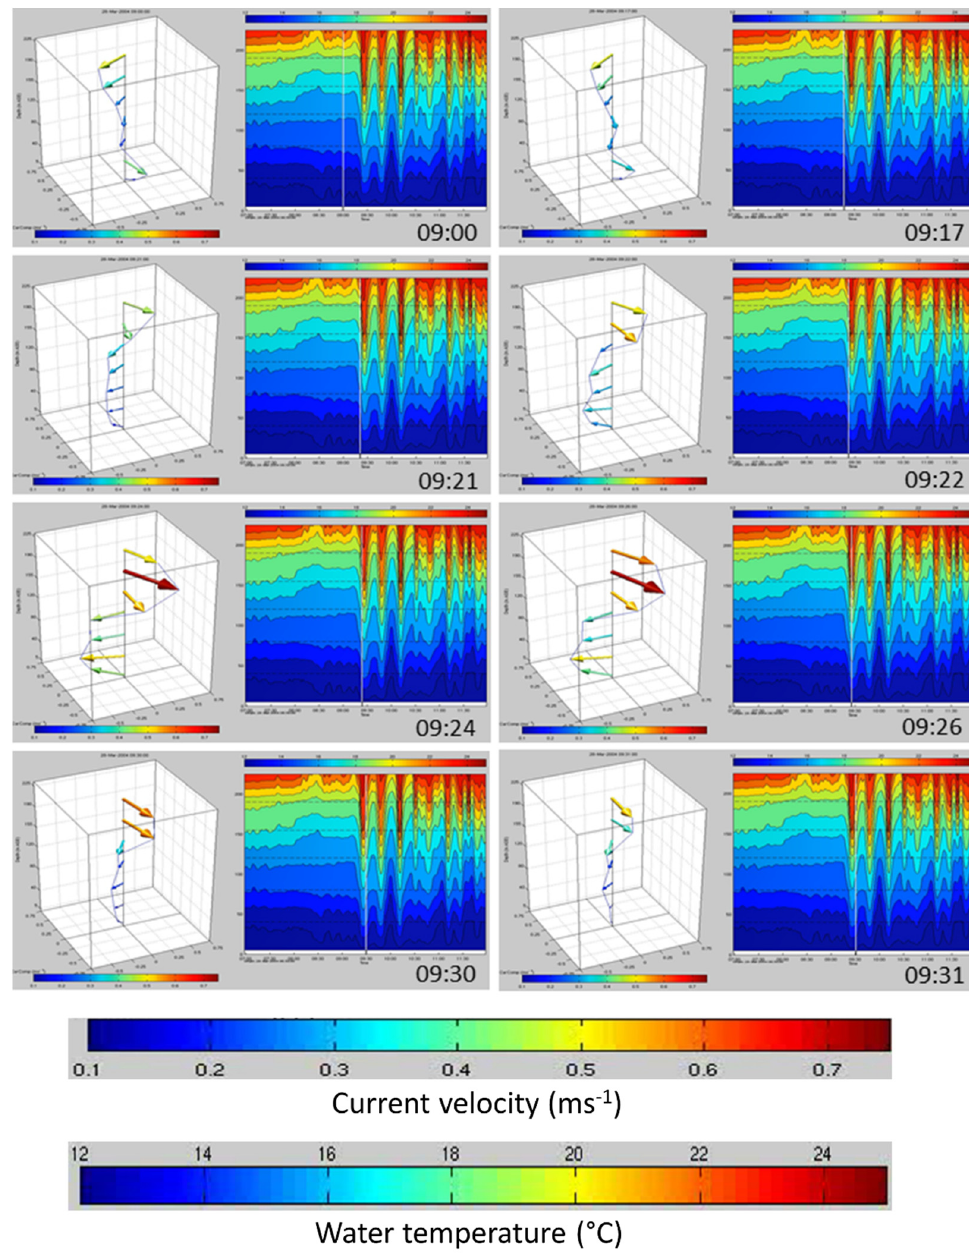
Figure 40. A 30 min time series of current and temperature profiles recorded by in situ sensors during the passage of an internal wave. The grey vertical line indicates the time of the sample; only the first cycle of the internal wave is sampled here. The axis labels are too small to read in this mosaic, so we explain them here. The vertical axis is depth, spanning 225 m from the sea floor to the sea surface. The horizontal axes measure current velocity components, spanning ± 0.75 ms − 1 . The colour bar beneath the current vector ‘boxes’ calibrates the current arrows, spanning the magnitude range 0–0.75 ms − 1 . The other colour bar, above the temperature histories on the right of each panel, spans the temperature range of 12–25 ◦ C. Both colour bars are reproduced below the main